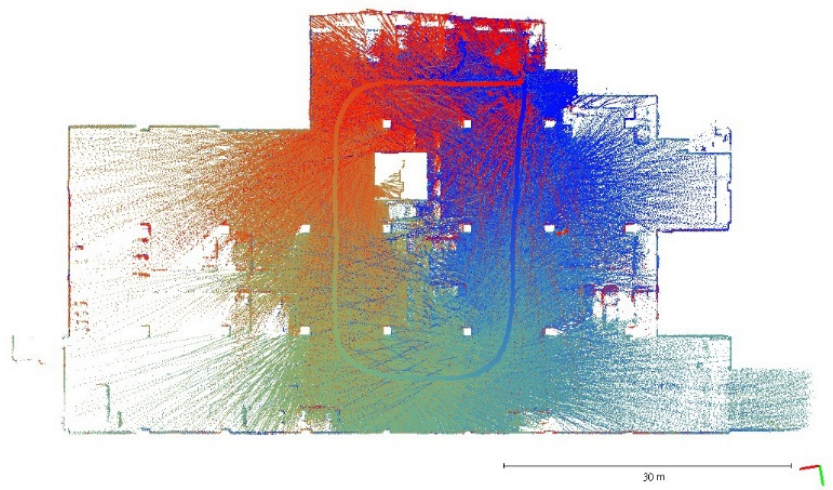
Figure 10. Point cloud colored by scanning time and the scanning trajectory of dataset DATA3.